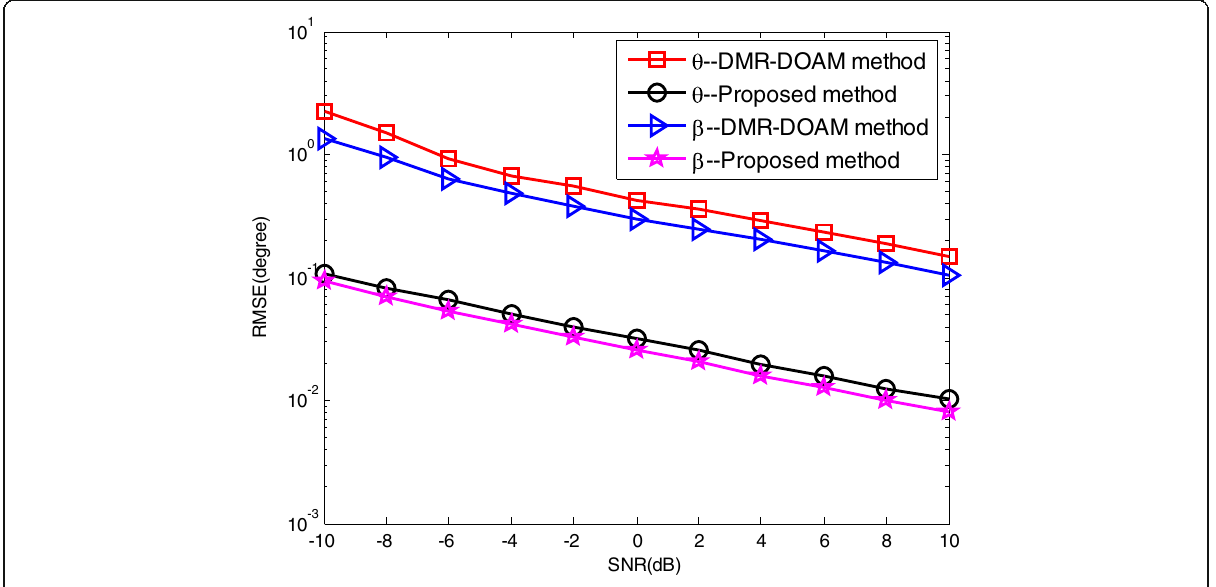
Fig. 2 The RMSE of the DOA estimates versus input